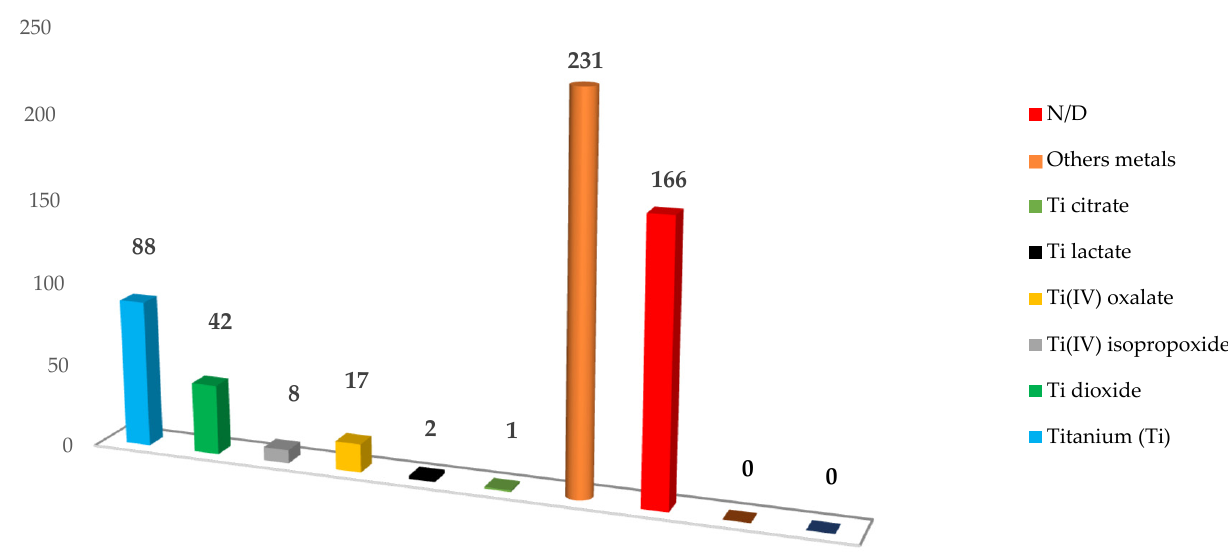
Figure 3. Titanium or other metal allergies in reported cases diagnosed with lesions potentially due to Titanium (alloy) and other metal nanoparticles released from dental implants and implant-sup- ported restorations.